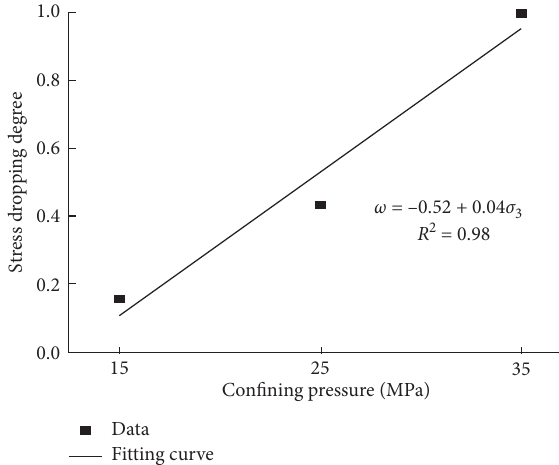
Figure 4: Relationship between peak strength and stress dropping